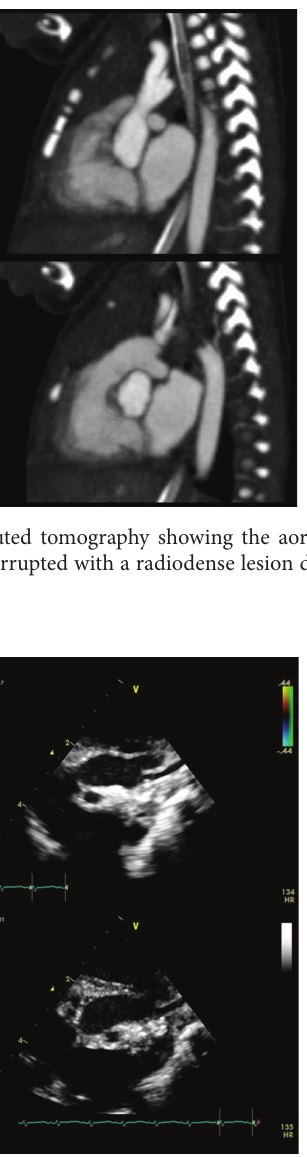
Figure 2: Echocardiogram showing the aortic arch with an echo- bright lesion within the lumen of the aorta just distal to the left subclavian